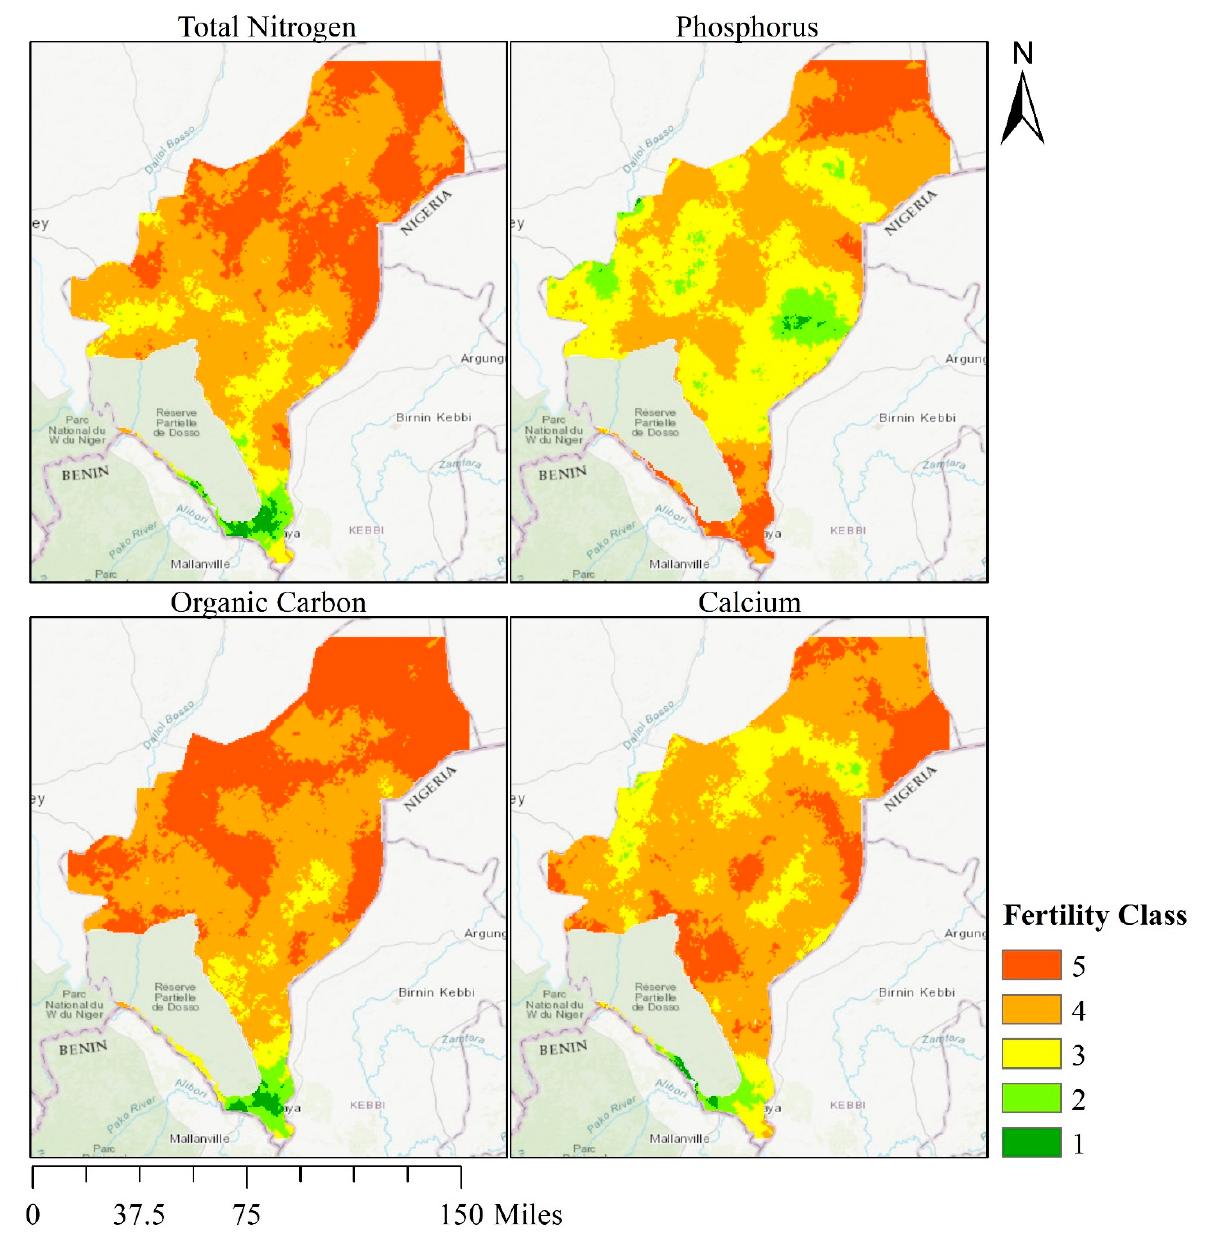
Figure 9. Interpolated, discretized fertility maps. Colors represent discretized soil fertility values where fertility class 1 is the highest fertility value and class 5 is the lowest fertility value.